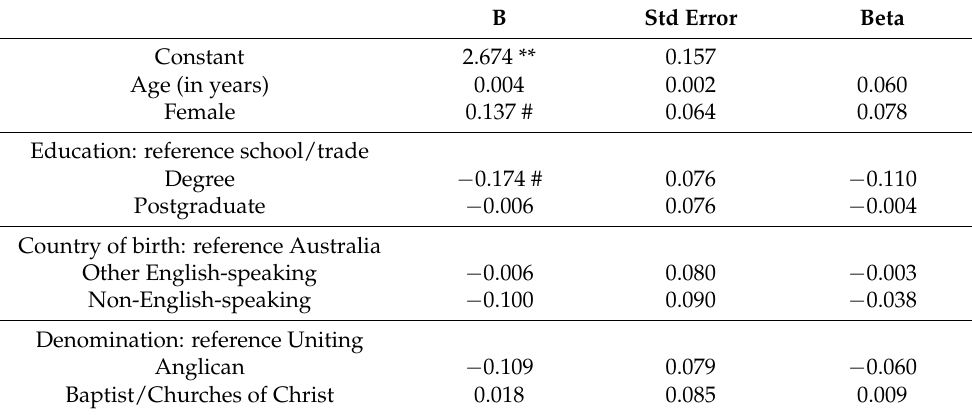
Table 10. Prediction of senior local church leader level of familiarity with DFV support services by demographics and